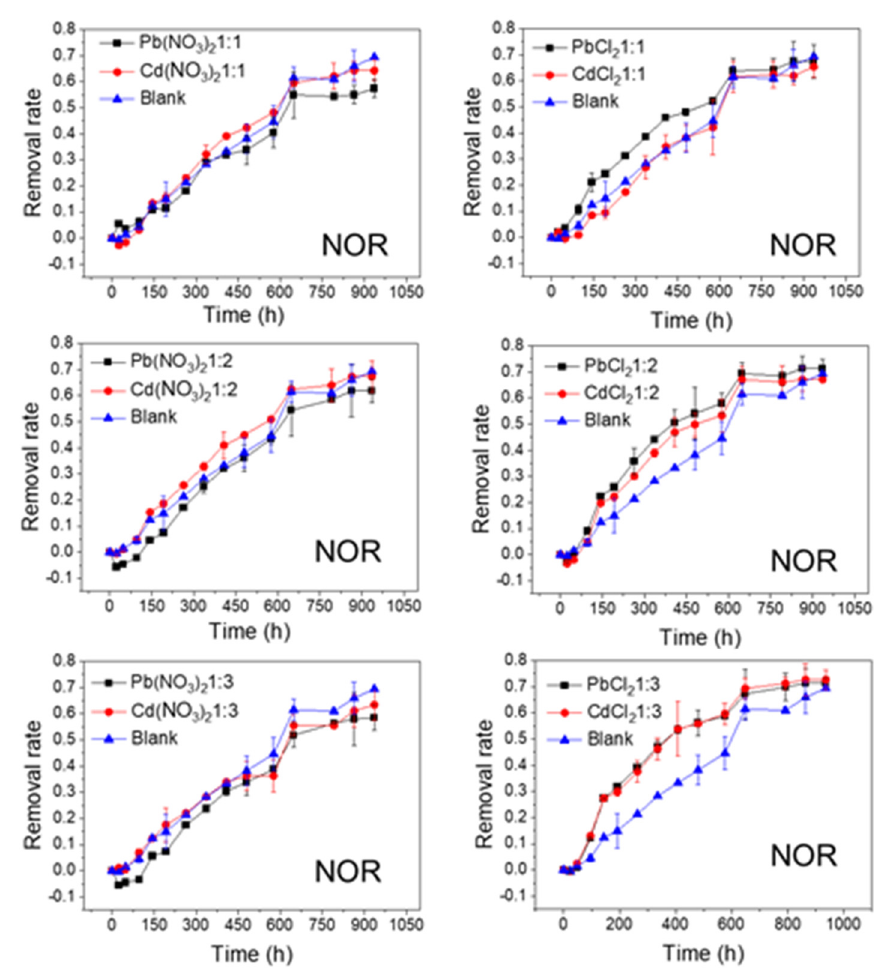
Figure 2. Photolytic degradation of NOR (0.012 mmol/L) with the effects of Pb 2+ and Cd 2+ at different molar ratios; Blank means no heavy metal ions added.